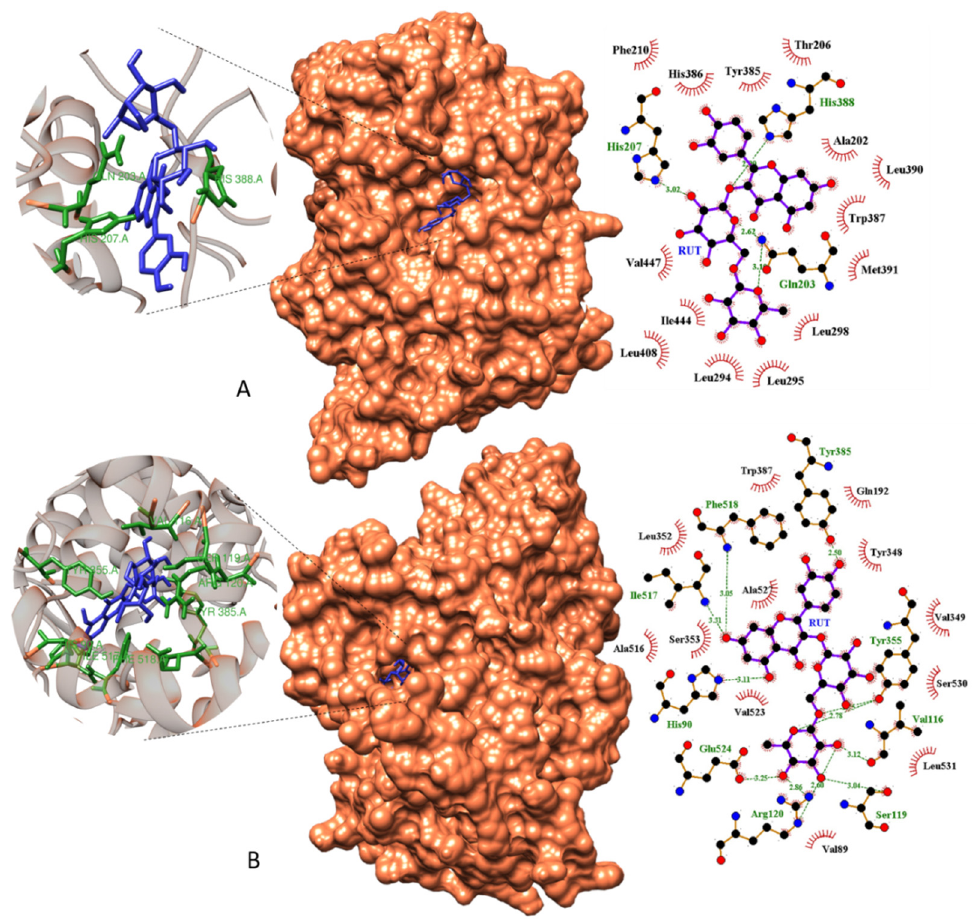
Figure 13. Molecular docking models of RUT with COX-1 ( A ) and COX-2 ( B ). Surface docking poses and Ligplot 2D diagrams show details of hydrogen bonds and hydrophobic interactions in complexes RUT/COX-1 ( A ) and RUT/COX-2 ( B ). RUT, rutin; COX, cyclooxygenase.